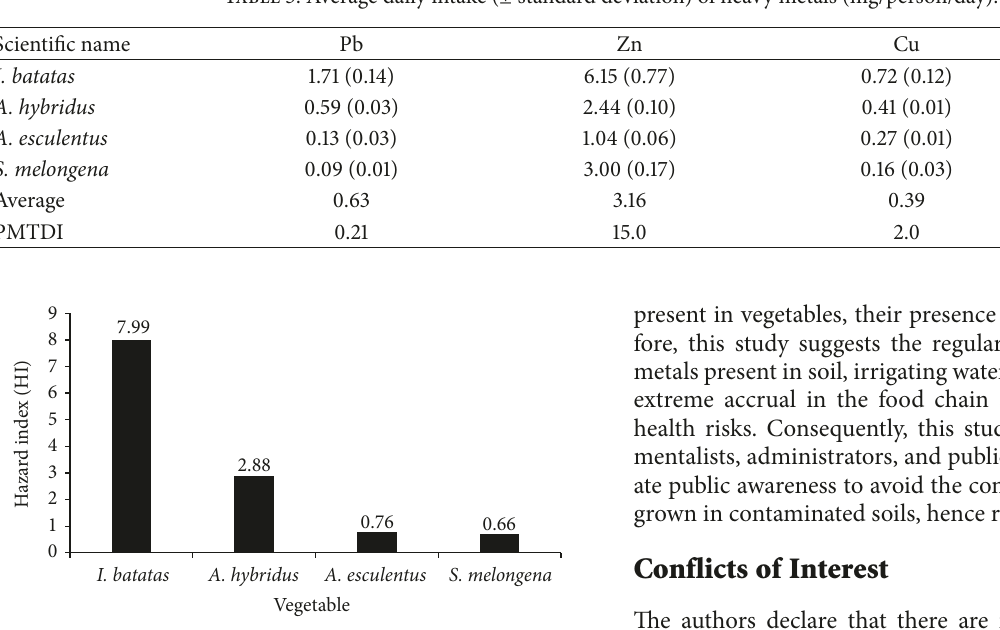
Figure 3: Hazard index (HI) for each studied